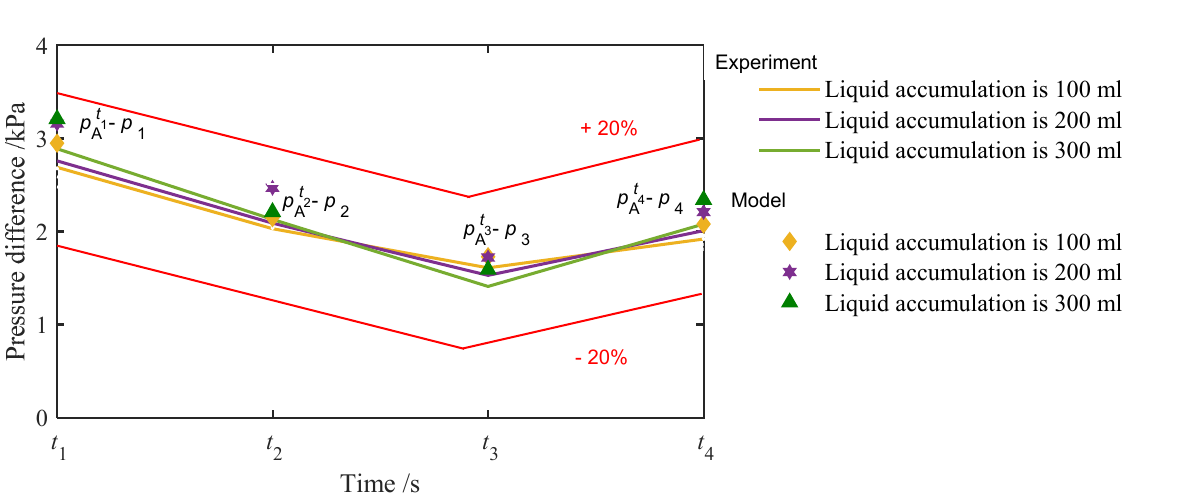
Figure 10. Slug flow pipeline pressure distribution 10°: ( a ) flow image in the pipeline at point A and P 4 at time t 1 ; ( b ) flow image in the pipeline at point A and P 4 at time t 2 ; ( c ) flow image in the pipeline at point A and P 4 at time t 3 ; ( d ) flow image in the pipeline at point A and P 4 at time t 4 . When the angle is 15 ° and the gas velocity is 9.89 m/s, the liquid accumulation volume in the pipe are 50 mL and 80 mL without slugging flow, and the deviation between the experiment and the model is within ±20%, as displayed in Figure 11. Compared with 5 ° and 10 ° , the pressure difference line slope of different liquid accumulation volume in 15 ° pipe is larger, indicating that the pressure change at point A and P 4 are more violent due to the increase in the angle. As with the above two angles, the pressure difference of slug flow in the pipe decreases first and then increases, which corresponds to the slug flow cycle of enter, discharge, and re-enter.